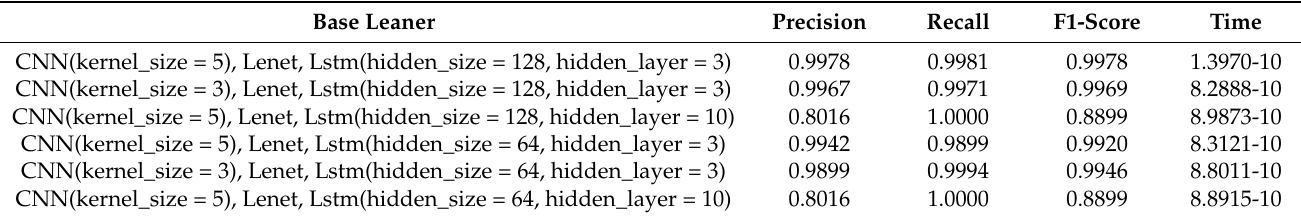
Table 6. Ablation